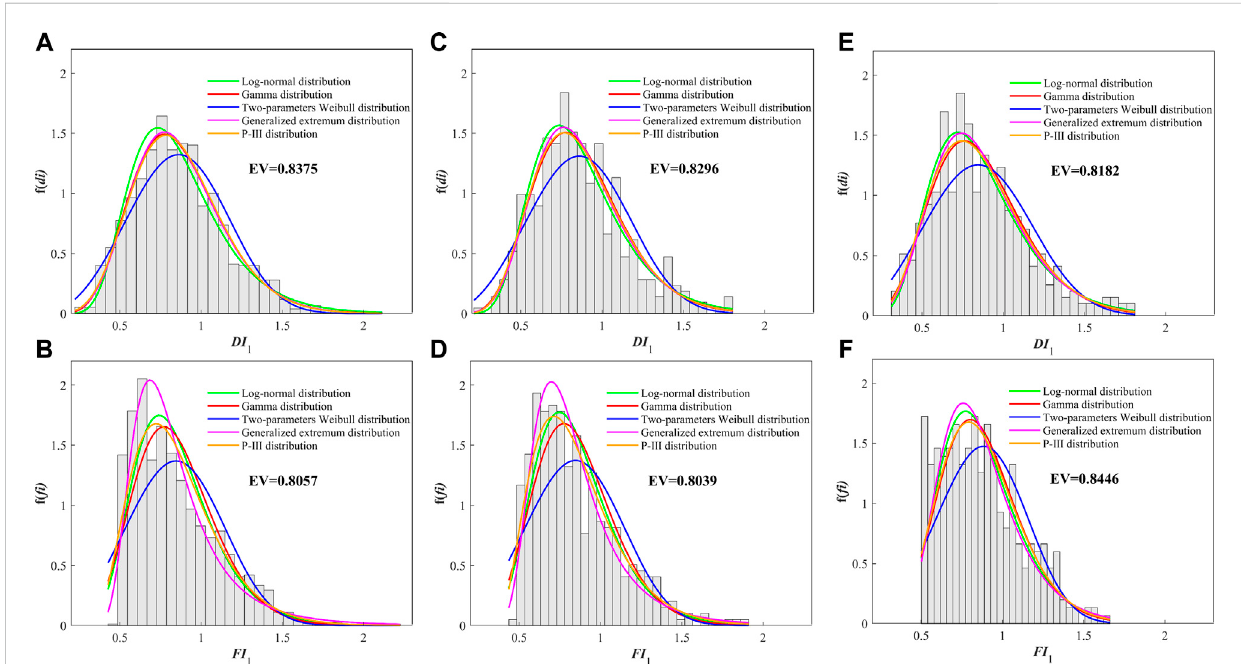
FIGURE 9 Frequency distributions of DI 1 and FI 1 for three sub-basins in the HRB. The various distribution curves are the fi tted frequency distribution. EV is the expectation value of the best- fi tted distribution function. (A) DI 1 in UB; (B) FI 1 in UB; (C) DI 1 in MB; (D) FI 1 in MB; (E) DI 1 in LB; (F) FI 1 in